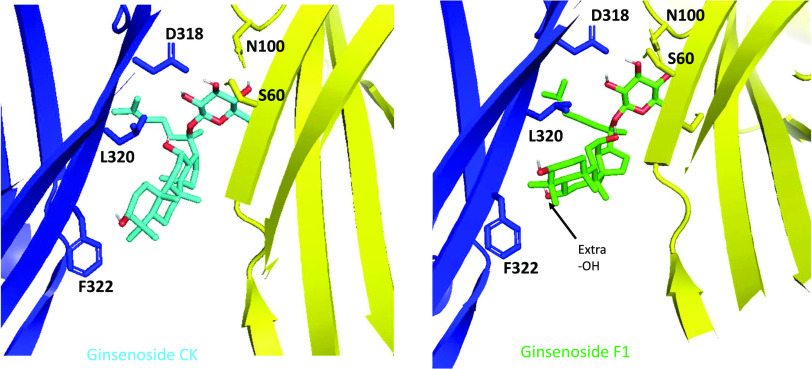
Molecular docking of ginsenoside-CK and ginsenoside-F1 to the central vestibule pocket of hP2X7. Ginsenoside-CK (cyan) docked into the central vestibule in the ATP-bound homology model of human P2X7 and right, ginsenoside-F1 (green) docked into the same site. Side chains of amino acid residues of hP2X7 implicated in interactions are shown.